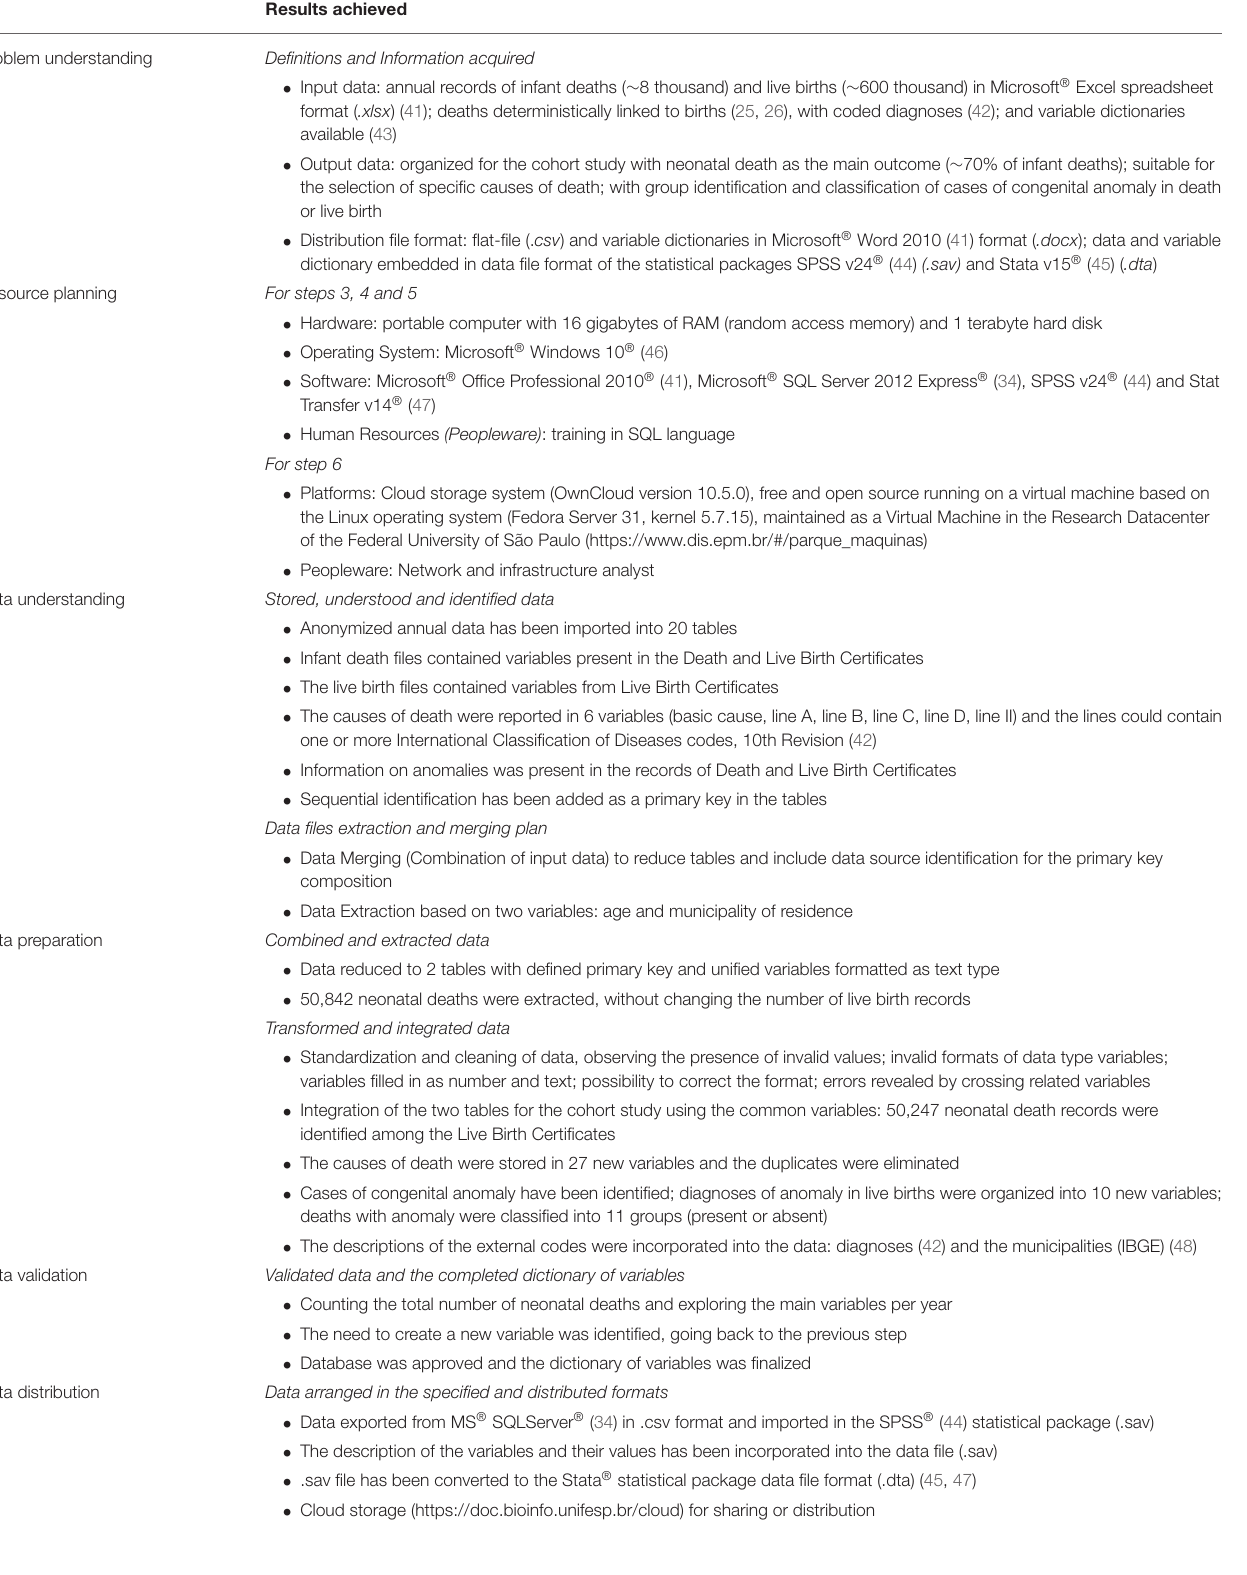
TABLE 3 | Results achieved at each step for ensuring the adequacy of structured secondary health data for specific use in quantitative